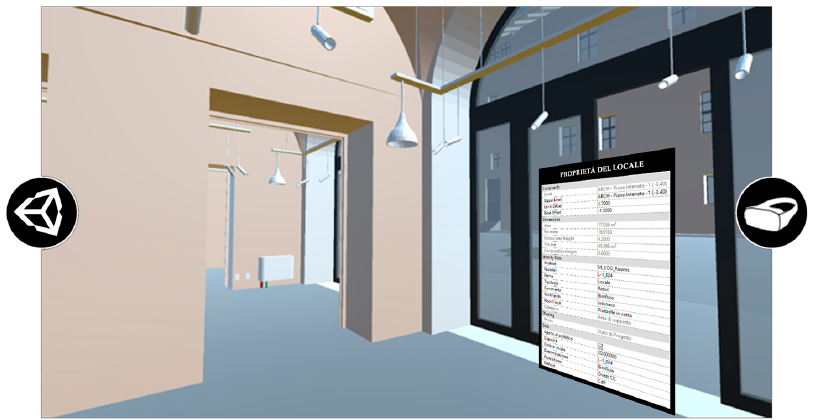
Figure 4. Room properties visualization with Oculus Rift.